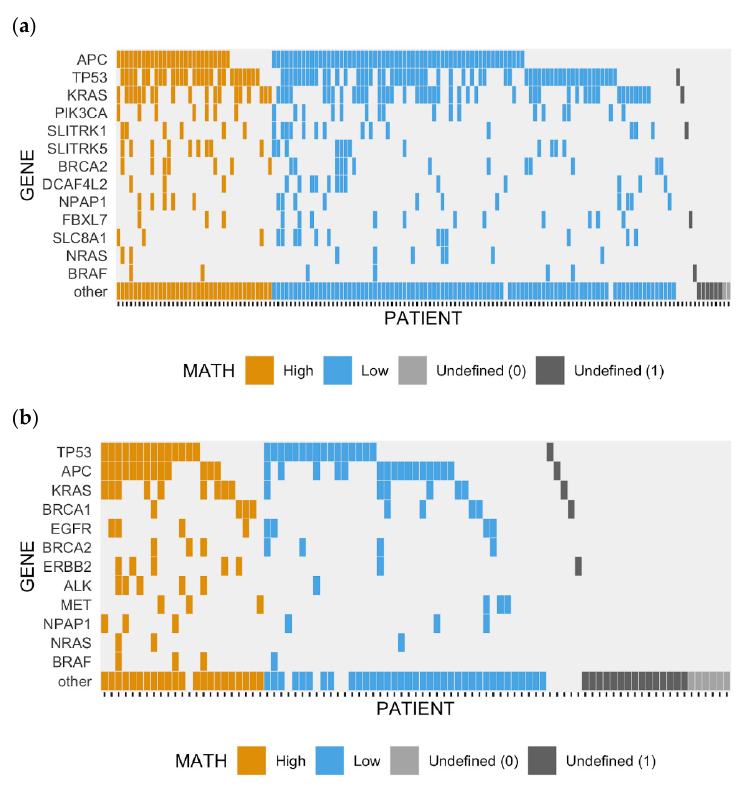
Figure A4. Most frequently mutated genes by MATH group. Mutation landscape for ( a ) pre-induction and ( b ) post-induction plasma. Filled tiles represent mutated genes. Each column represents a patient. Patients are grouped and colored by MATH (High, Low, and Undefined); Undefined are samples with 0 or 1 somatic mutations. The top 10 most frequently mutated genes and NRAS and BRAF are presented. “Other” refers to other genes or no mutations for samples with 0 variants.